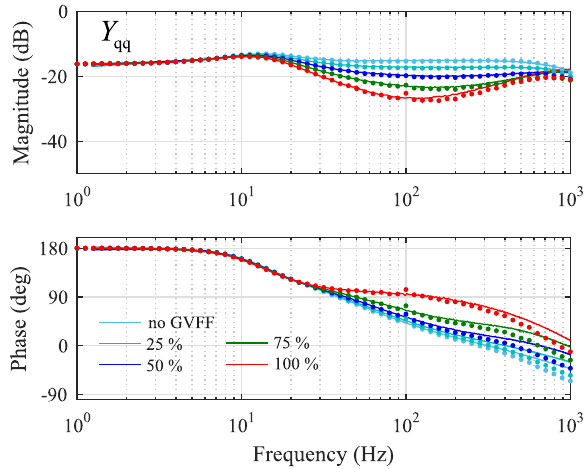
Figure 17. Admittance q-component with different gains for grid voltage feedforward.